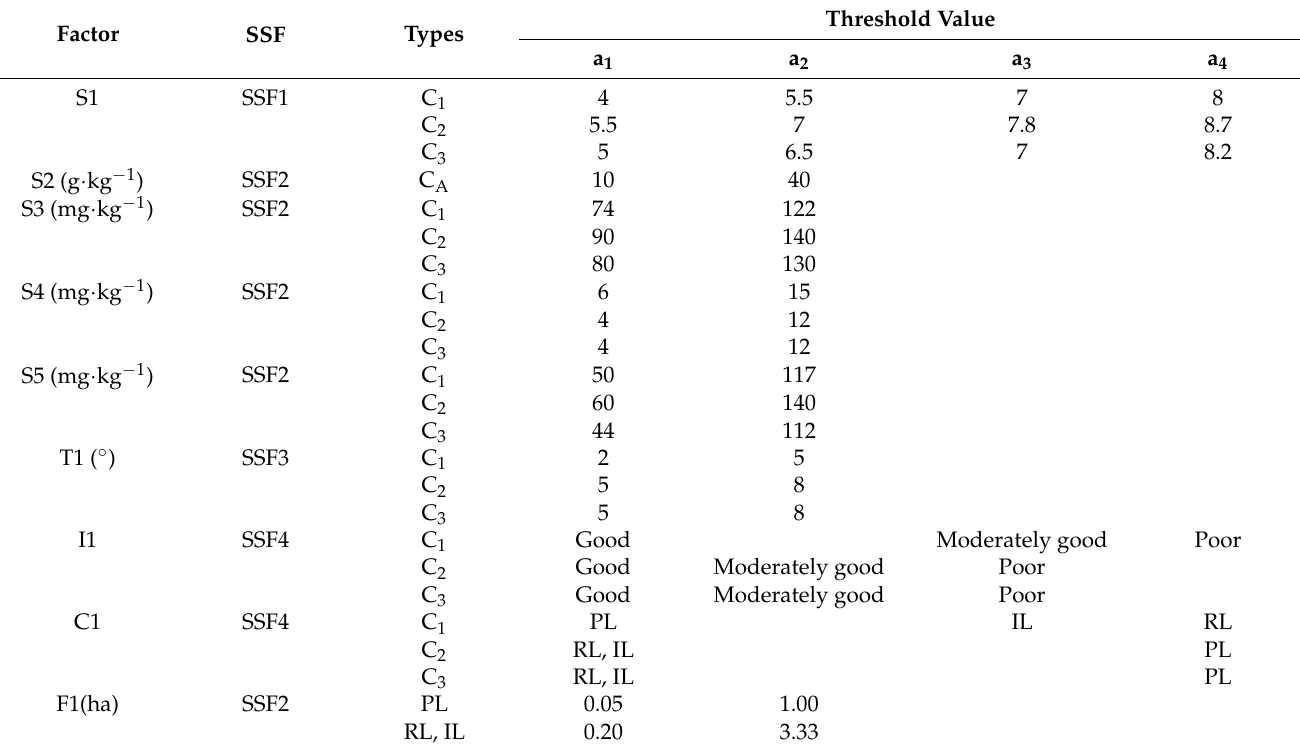
Table 1. Quantitative methods and thresholds of the evaluation